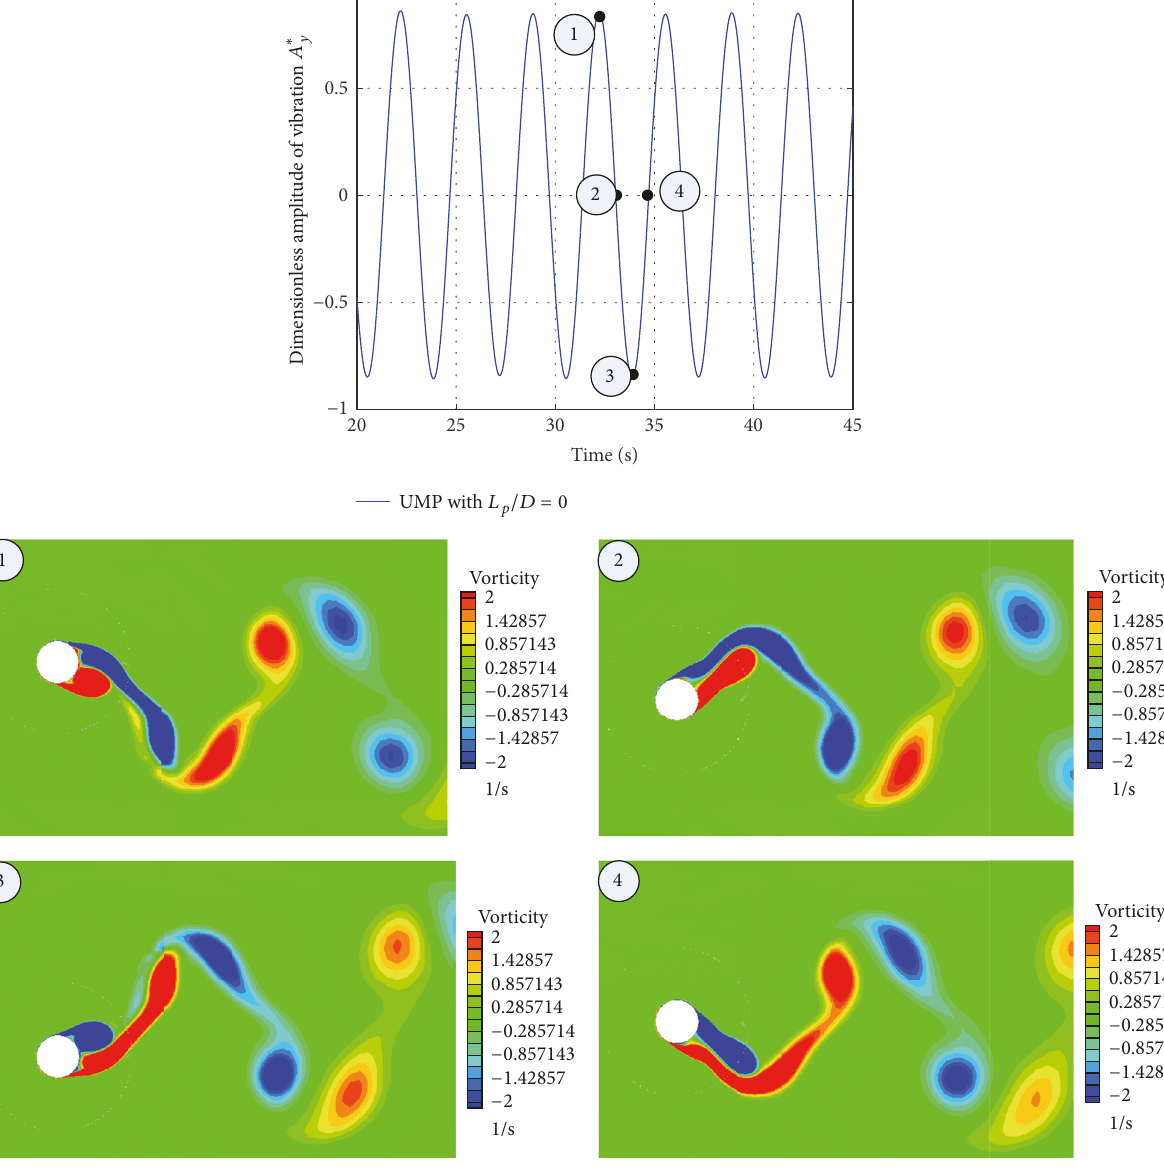
Figure 24: The vorticity cloud images of bare